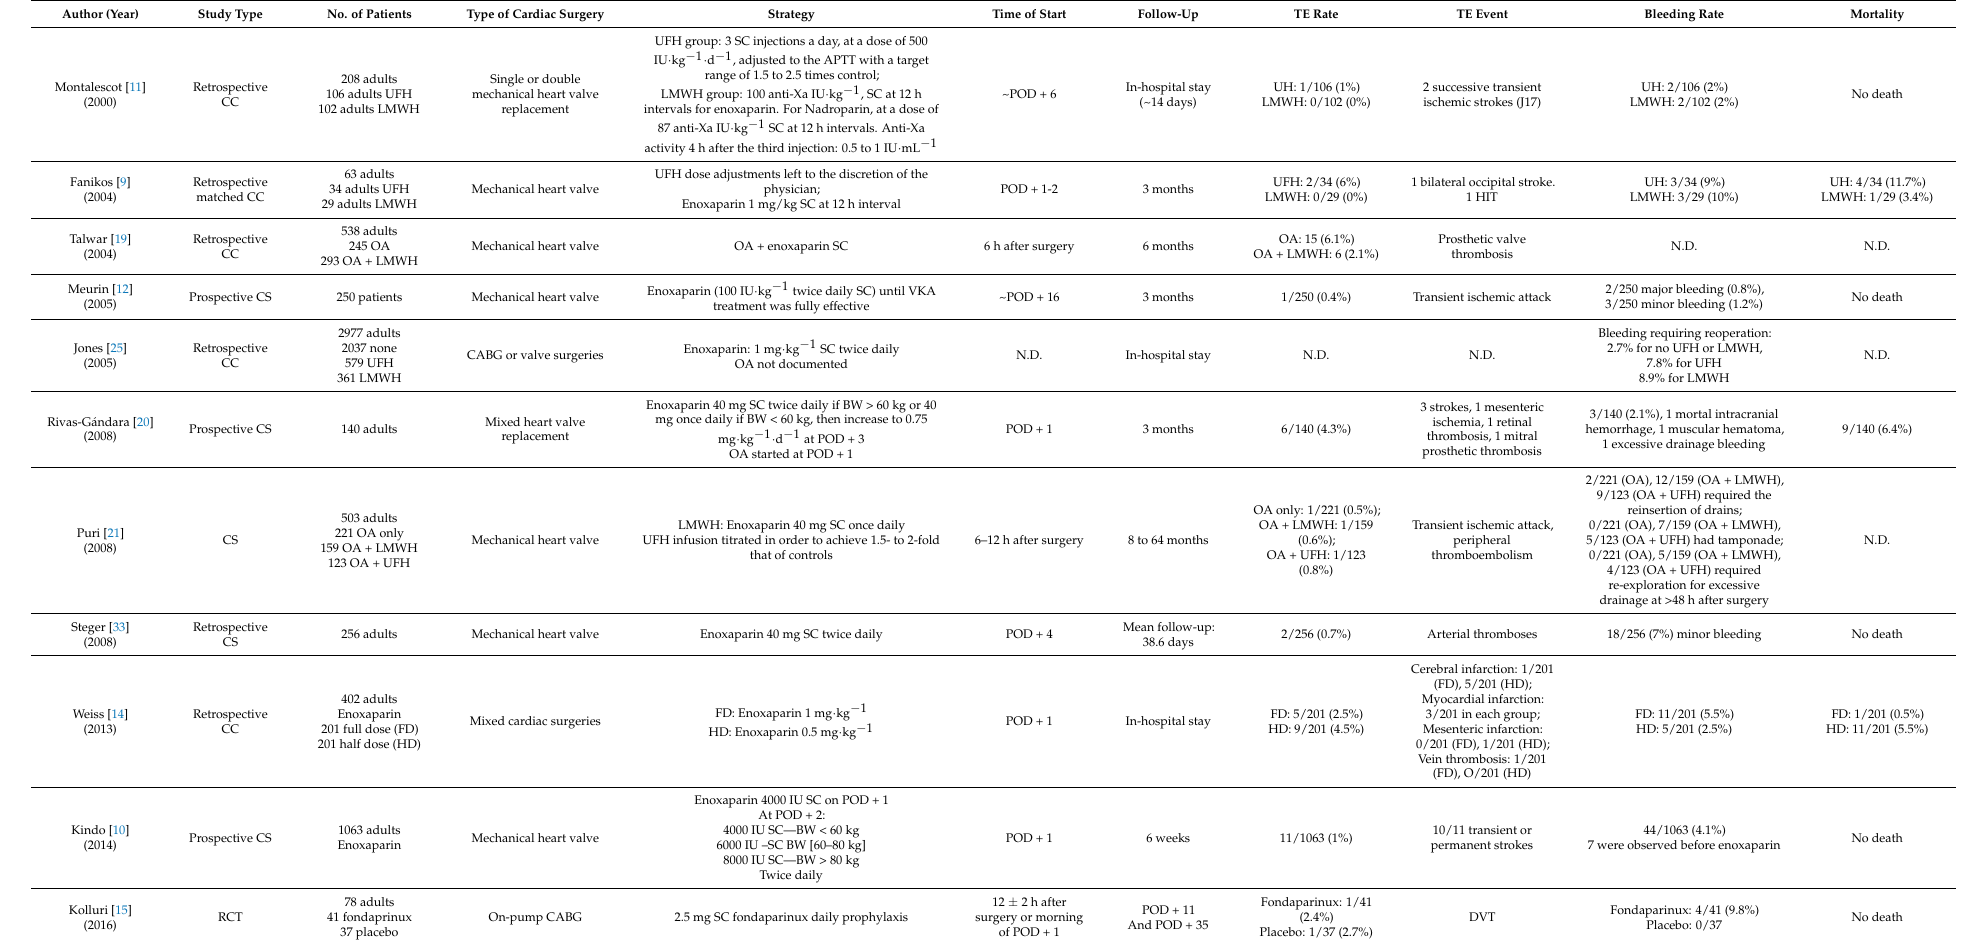
Table 2. Characteristics of studies with low-molecular-weight heparin use in the early postoperative course of cardiac